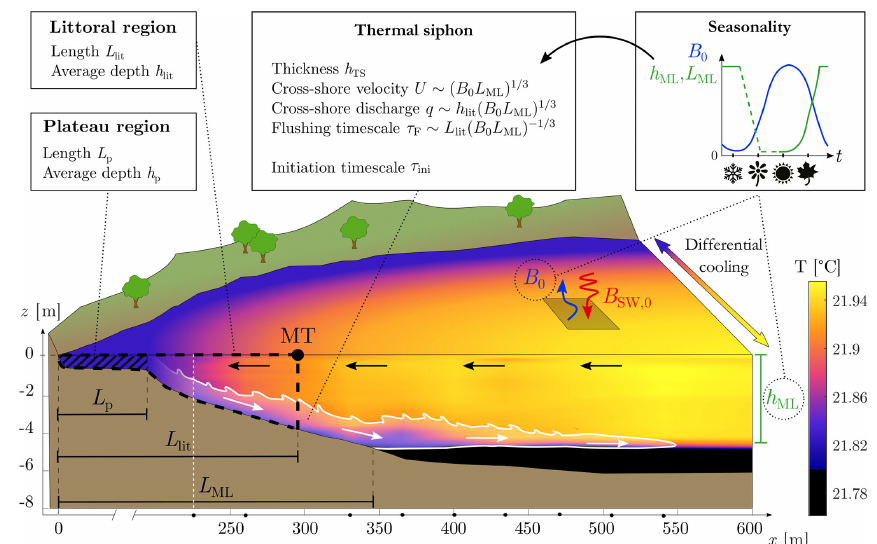
Figure 1. Data-based schematic of the cooling-driven thermal siphon. The schematic shows the plateau, littoral, and mixed regions; the seasonality of the forcing; and the variables used for the transport scaling. Here, the littoral zone is the region upslope of the MT mooring, where the current velocity is measured and transport variables are calculated. The cross-shore temperature field is linearly interpolated from a transect of conductivity–temperature–depth (CTD) profiles collected on the morning of 22 August 2019 (08:20–08:50UTC), from x = 225m (white dashed line) to x = 714m. Black dots on the x axis show the location of the profiles. The green dashed line in the seasonality diagram corresponds to the transition period between the mixing period (winter) and the stratified period (summer), when the mixed layer is not well